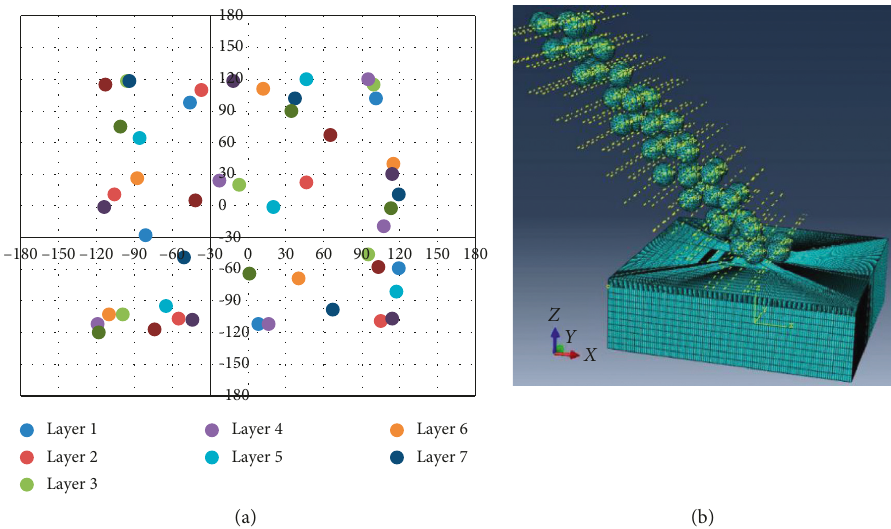
Figure 17: Random particle model and location of the drop. (a) Drop location map. (b) Random impact model grid.